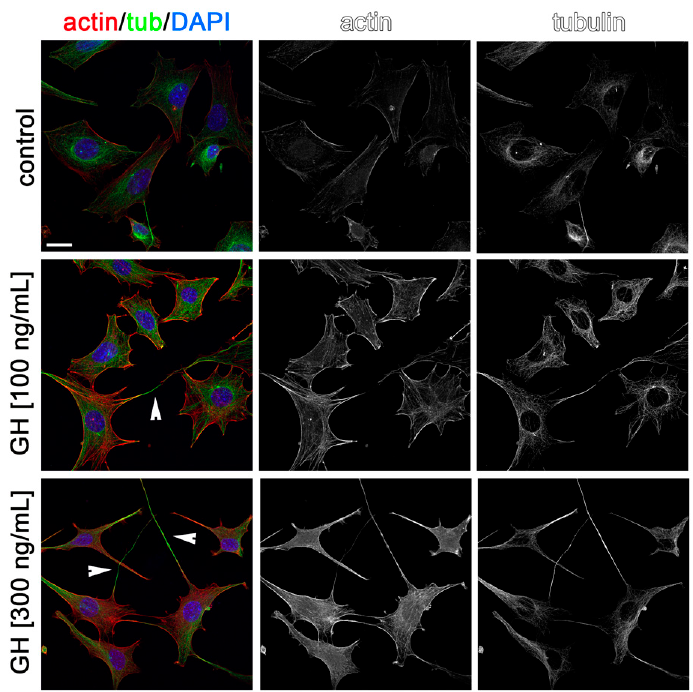
Figure 6. Growth hormone (GH) treatment alters GN11 cytoskeleton organization. GN11 cells treated with GH (at 100 and 300 ng/mL) were immune-labeled for F-actin (red) and α -tubulin (green) to reveal microfilament and microtubule organization, respectively. Single channels are shown as black and white images. Arrowheads point at cells displaying a prominent fusiform morphology. Scale bar: 25 µm.